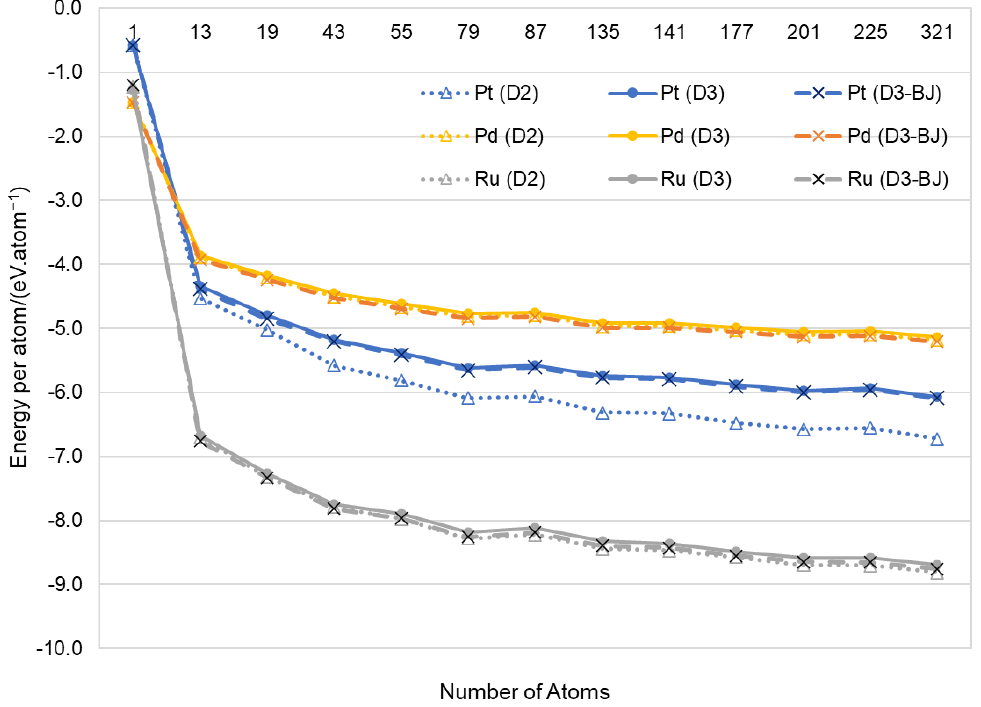
Figure 7. Energy per atom as a function of size for spherical Ru, Pd and Pt nanoparticles calculated with the three modelling methods, DFT-D2, DFT-D3 and DFT-D3(BJ). Comparing the energy profiles for the five nanoparticle types, we can see that more than 200 atoms are needed before the energy per atom reaches the bulk energy for each respective metal type. It is also at this point that the number of bulk atoms matches or exceeds the surface atoms. 4. Conclusions Density functional theory calculations have been employed to gain detailed under- standing of the behaviour of different types of nanoparticles, compared to the fcc bulk metal and extended surfaces. It was determined that the DFT-D3(BJ) dispersion method provides the best agreement between calculated surface energies and lattice parameters compared to experimental values. Bulk, surface and nanoparticle calculations showed that the DFT-D2 method used for Pt overestimates the exchange correlation, leading to higher energy values that could erroneously suggest structures to be more stable than they are in reality. The Wulff morphology of all three metal types showed that the (111) surface is the dominant surface but that the (001) and (011) surfaces are also expressed in the particle morphologies. However, when using the DFT-D3 method, the Pt nanoparticle only showed the presence of the (111) and (011) surfaces, indicating the sensitive balance be- tween surface energies and the resulting morphologies. Five different types of Ru, Pd and Pt nanoparticles of different sizes were considered, i.e., icosahedral, decahedral, cuboctahedral, cubic and spherical particles. Pt atoms at the surface moved into the bulk metal, leading to contraction that could explain the smaller nanoparticle sizes. Comparing the size of each metal, it was seen that Pt and Pd had sim- ilar sizes, with Ru being slightly larger. Overall, the energy per atom increases (becoming more negative) as the particle size increases and extrapolation to larger sizes indicates convergence to bulk energy values, irrelevant of the shape of the particular nanoparticle. The calculations showed that as soon as the surface-to-bulk ratio of the number of atoms